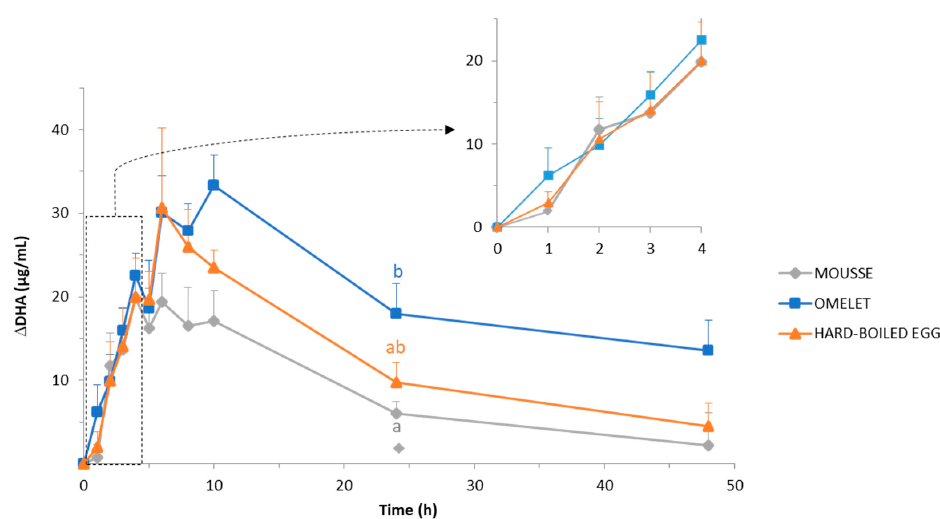
Figure 6. Base-line adjusted DHA concentration in plasma, expressed in µg DHA/mL plasma, throughout 48 h postprandial after the ingestion of the DHA-enriched omelet, hard-boiled egg, and mousse. Time points between 0 and 4 h are zoomed in the upper right-side of the figure. Means and SEM were calculated from n = 7 pigs. Time effect was significant ( p < 0.001; nparLD analysis and post hoc Tukey test). Time × matrix and matrix effects were not significant. For a given digestion time, different letters display significantly different mean values ( p < 0.05).